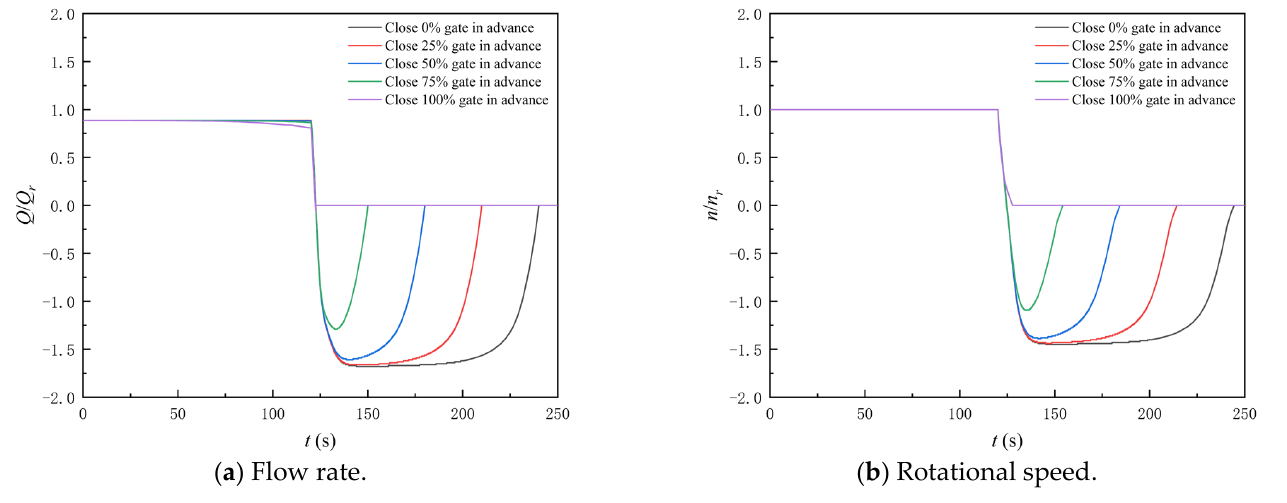
Figure 20. Variation of flow and rotating speed with time under different gate closure schemes (TTGC: 120s).